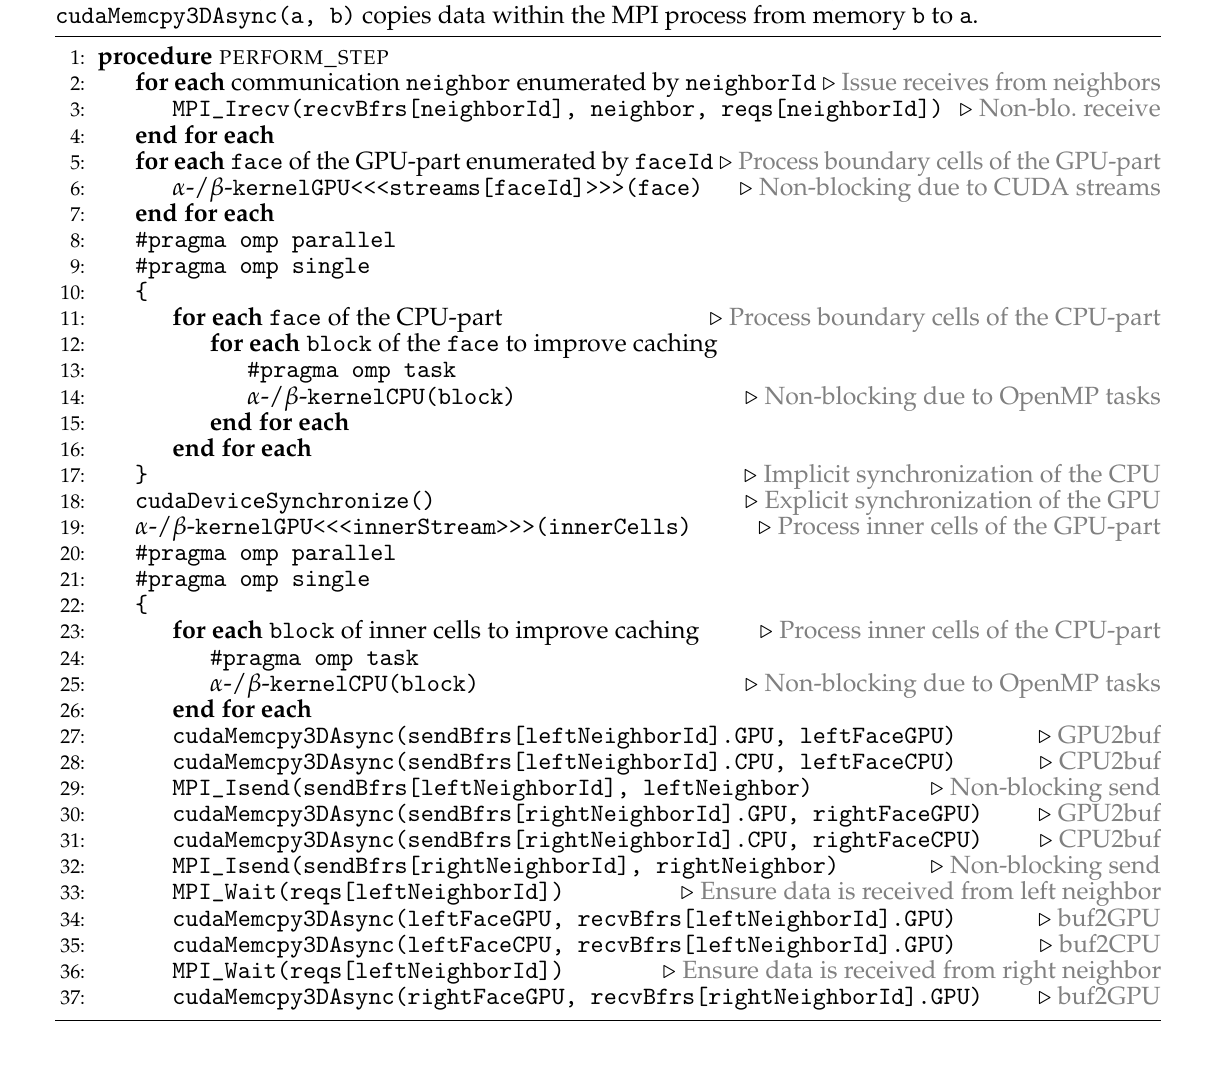
Algorithm 1 Pseudocode of an MPI process to update its subdomain and to exchange